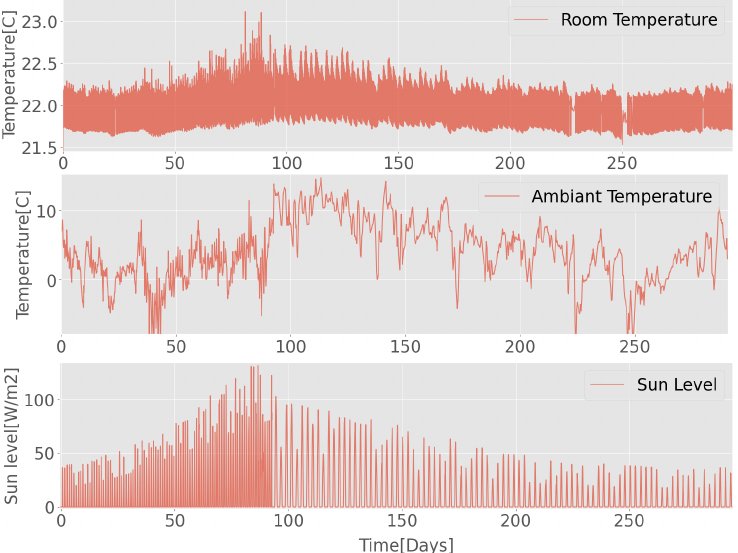
Figure 2. Simulation results of one heating season, with a traditional controller and outside compen- sated supply